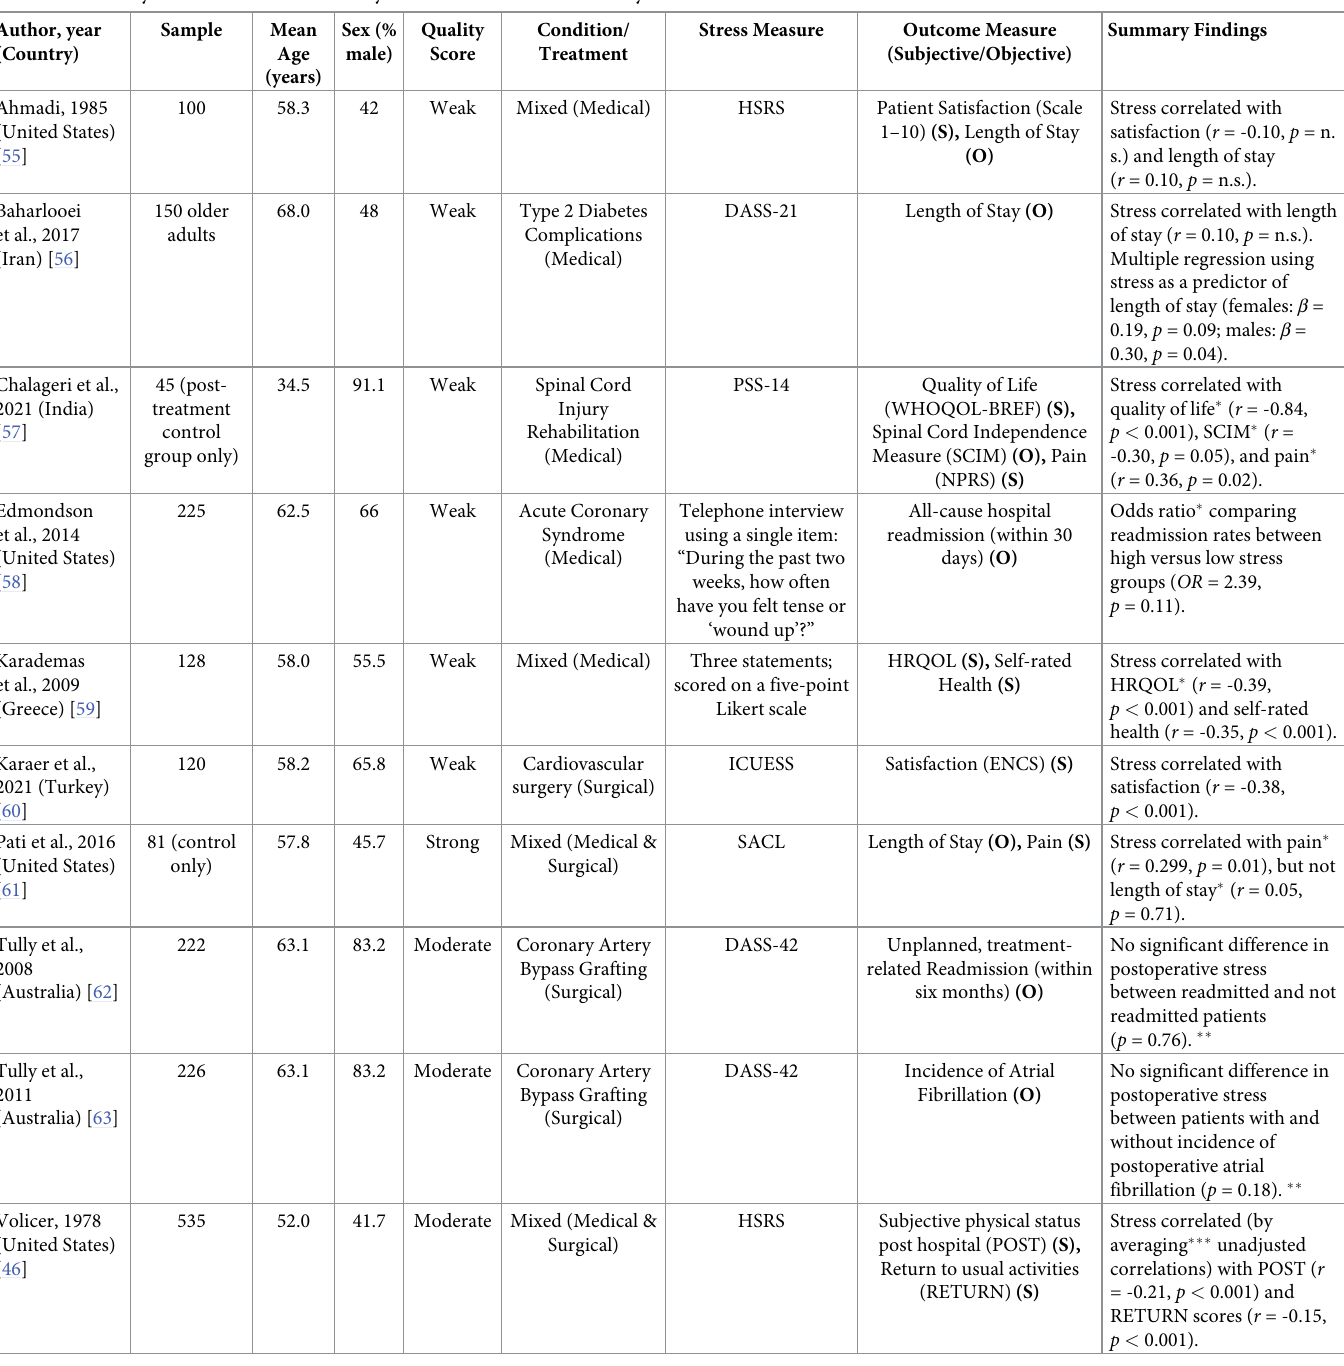
Table 2. Summary of studies included in the systematic review and